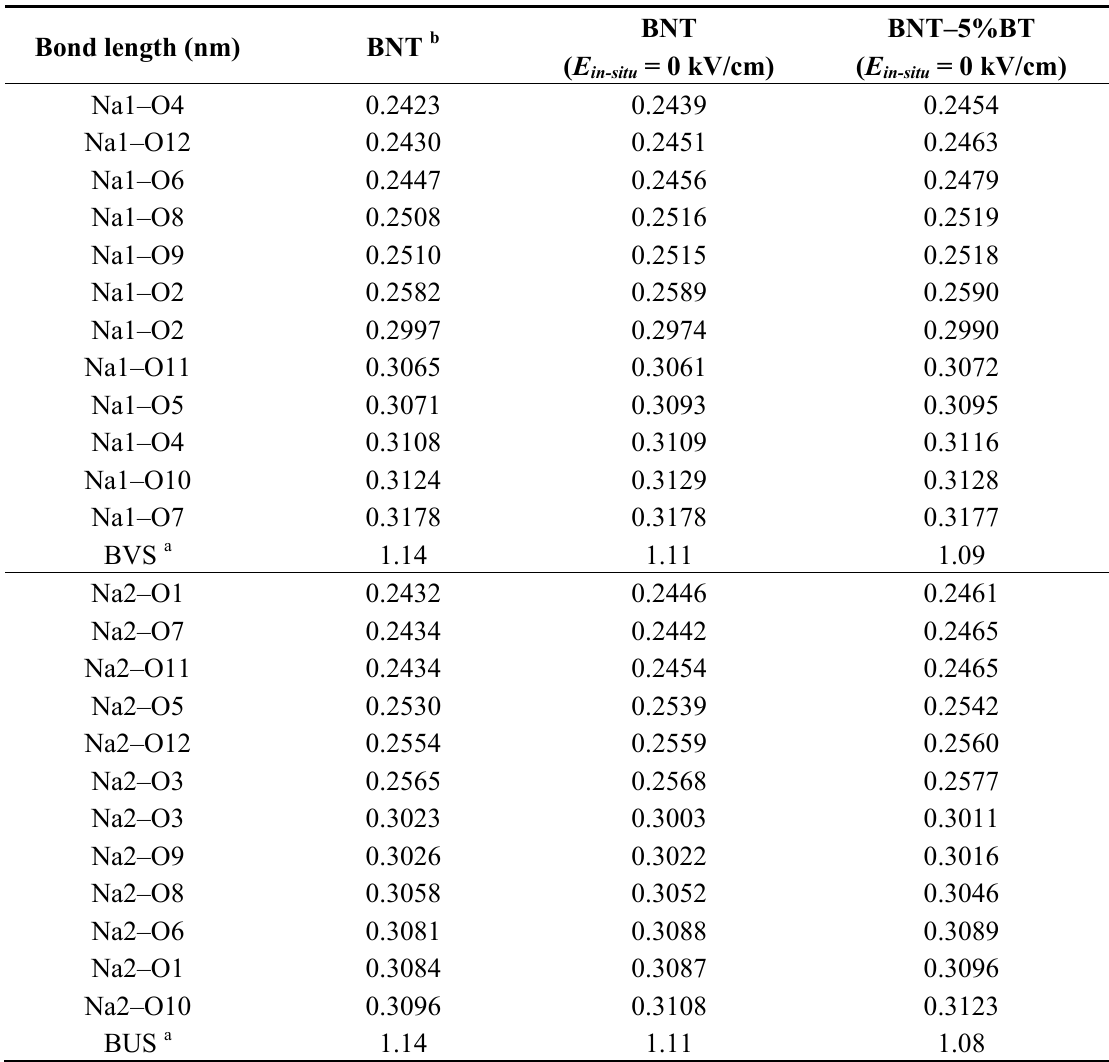
Table 3. Bond lengths of Na–O obtained by the DFT calculations for BNT and BNT–5%BT with E = 0 kV/cm in the Pc in-situ